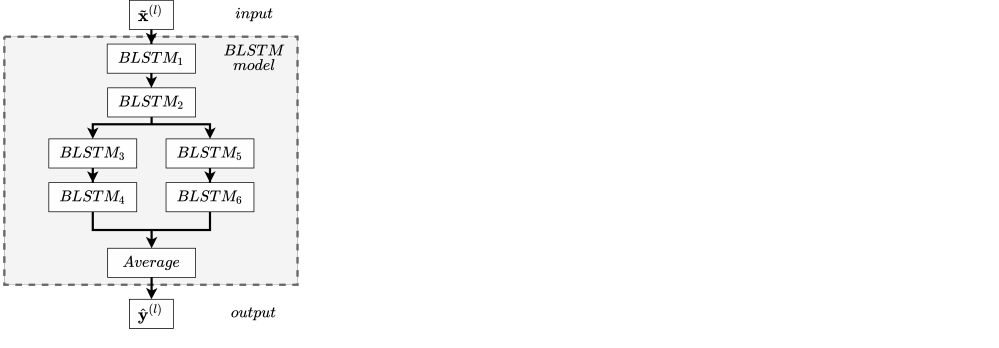
Figure A2. BLSTM model: Same model as the proposed MDN model, without the added MDN layer. RMSE loss function has been used.